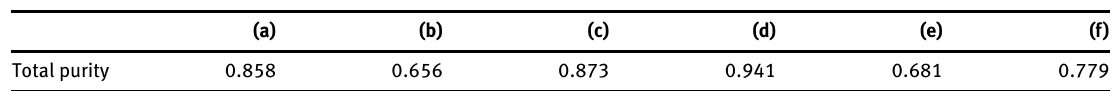
Table 3: Clustering